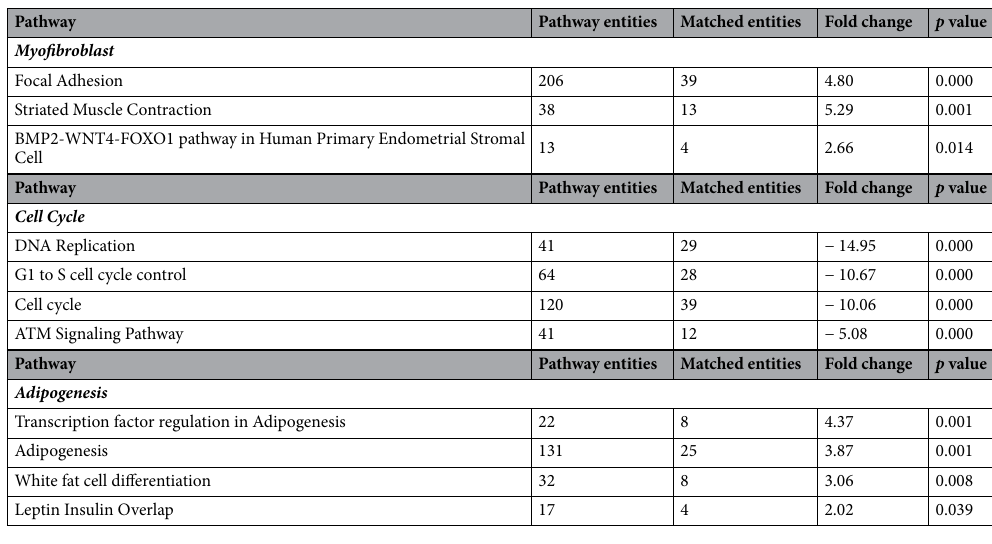
Table 4. Statistically significant pathways.